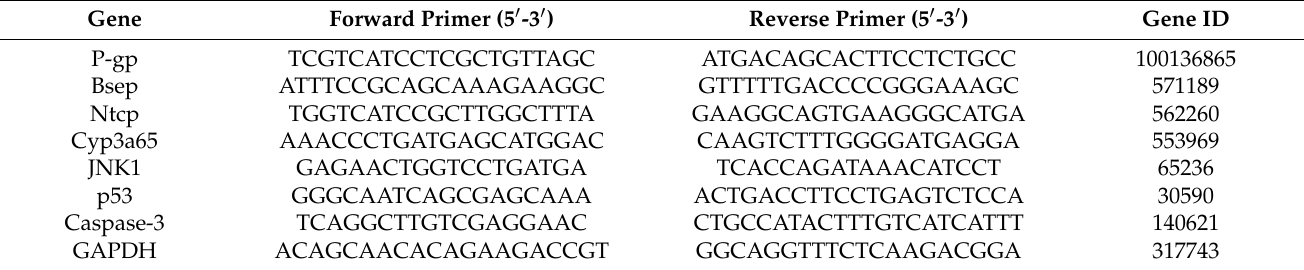
Table 1. qRT-PCR primer